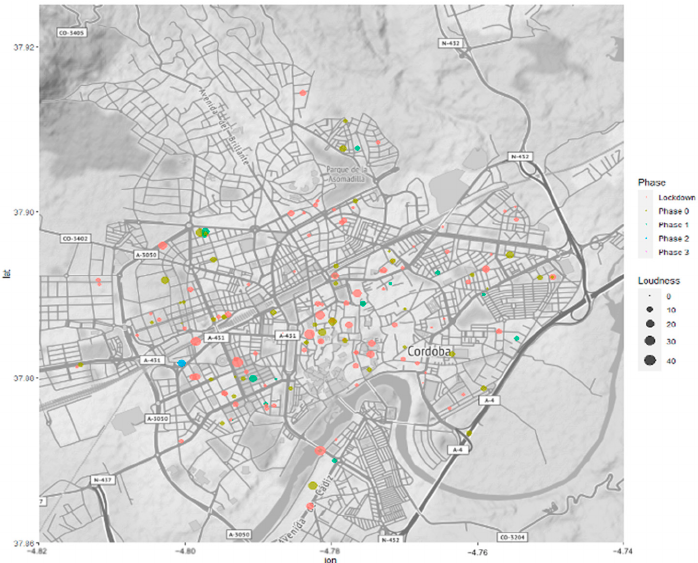
Figure 7. Bubble map of Loudness during outbreak: light red—lockdown; light green—phase 0; green—phase 1; blue—phase 2; red—phase 3.